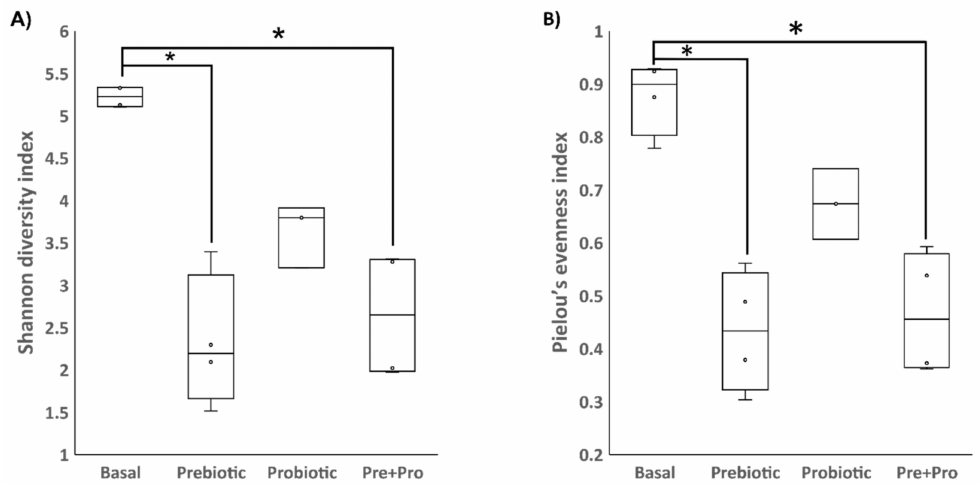
Figure 2. Comparing the alpha diversity using Shannon diversity ( A ) and Pielou’s evenness ( B ) in- dices to compare the transient intestinal microbiota of red drum fed the different dietary treat- ments. The bar and asterisks represent significant differences ( p < 0.05) detected between the dietary treatments.